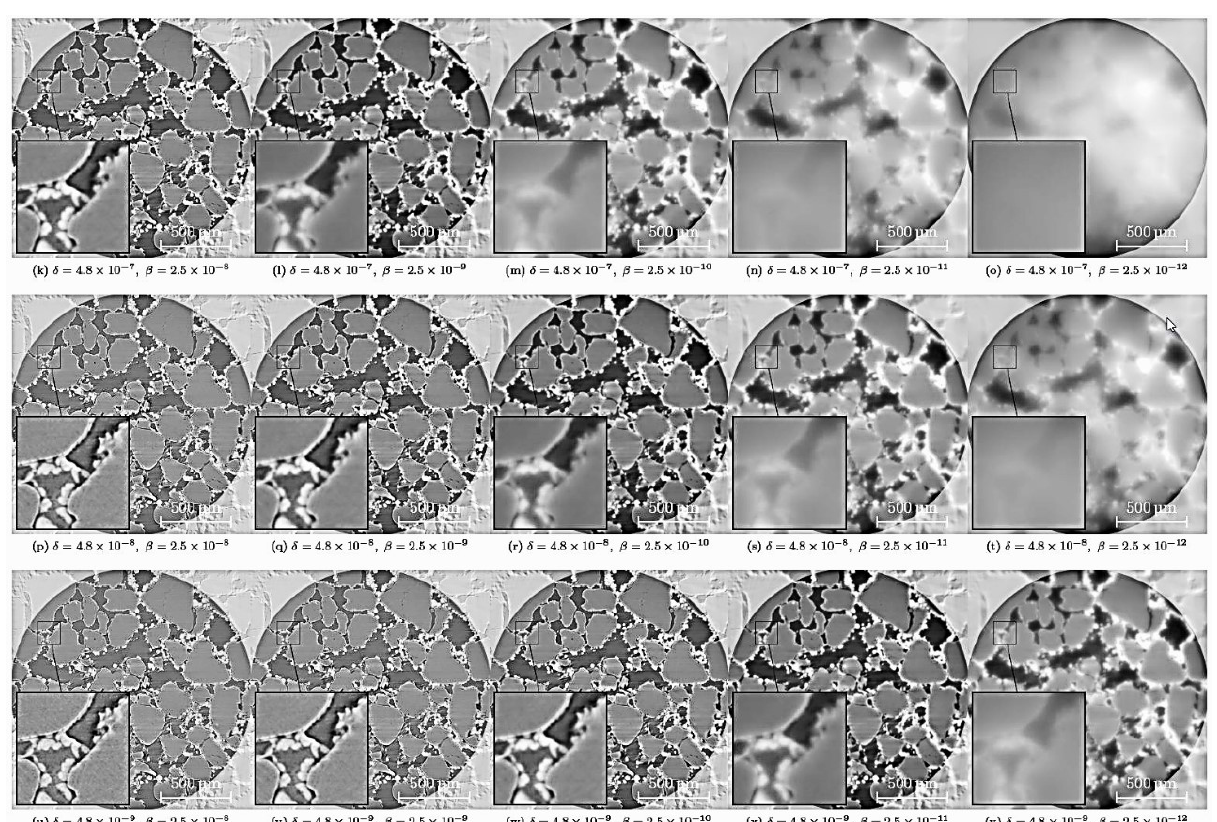
Figure 3. Selected results of the approach to enhance the contrast between the gaseous and aqueous phase by applying the reconstruction algorithm of Paganin on a 2560 × 2560 voxel 2-D slice. The insets show a 75 × 75 pixel size region of interest, magnified 5 ×